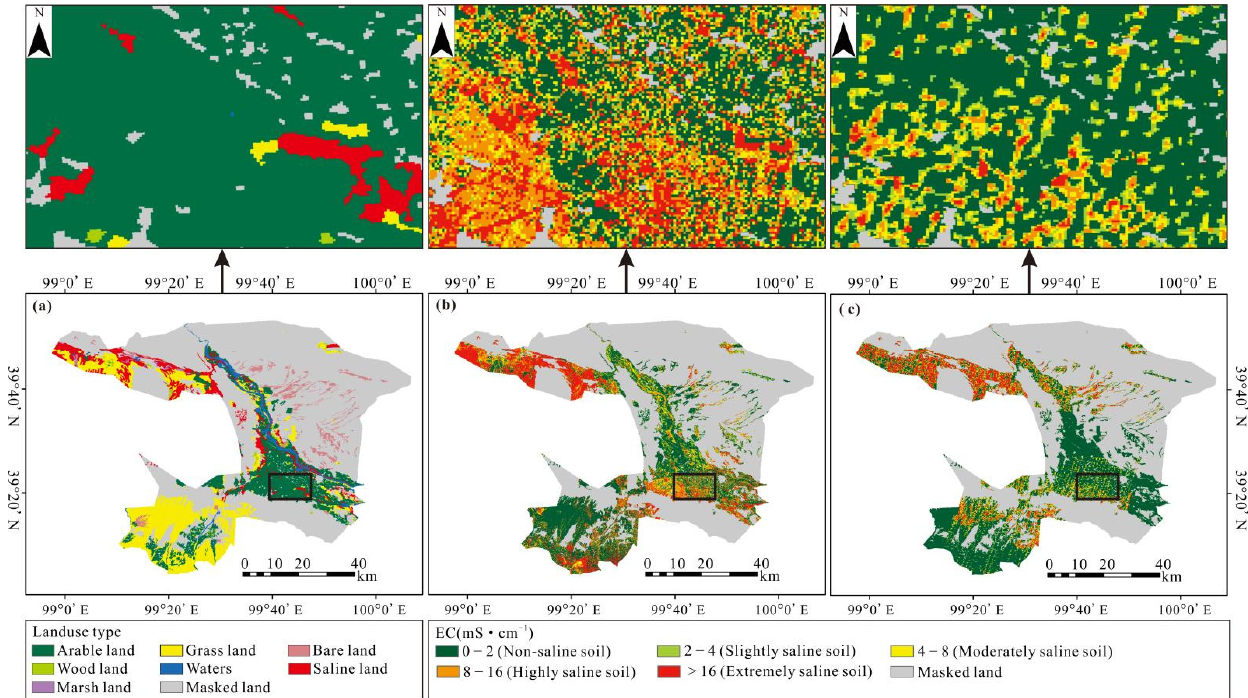
Figure 10. Land use map ( a ) and soil salinity distribution map based on GF-5 ( b ) and HJ-1A ( c ) spectra in the study area (the land use data was downloaded from https://www.resdc.cn/Default. aspx (accessed on 30 January 2022) and the classification standard of saline soil referred to the research of Ivushkin et al. [66]). The masked area included construction land, desert, Gobi and other unused land. The distribution of saline soil predicted by GF-5 and HJ-1A was similar (Figure